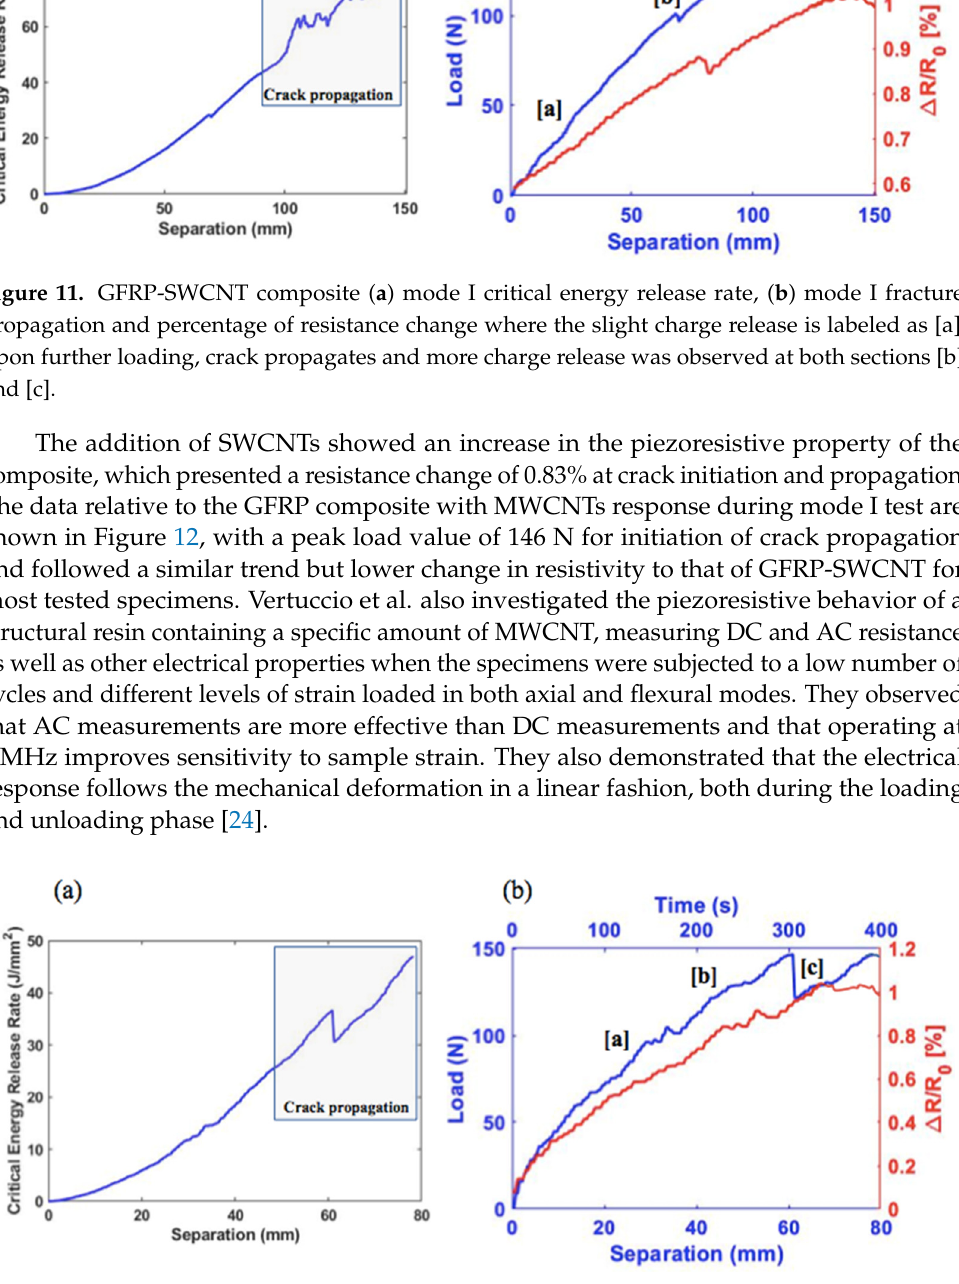
Figure 12. GFRP-MWCNT composite ( a ) mode I critical energy release rate, ( b ) mode I fracture propagation and percentage of resistance change where the slight charge release is labeled as [a]; upon further loading, crack propagates and more charge release was observed at both sections [b] and [c].